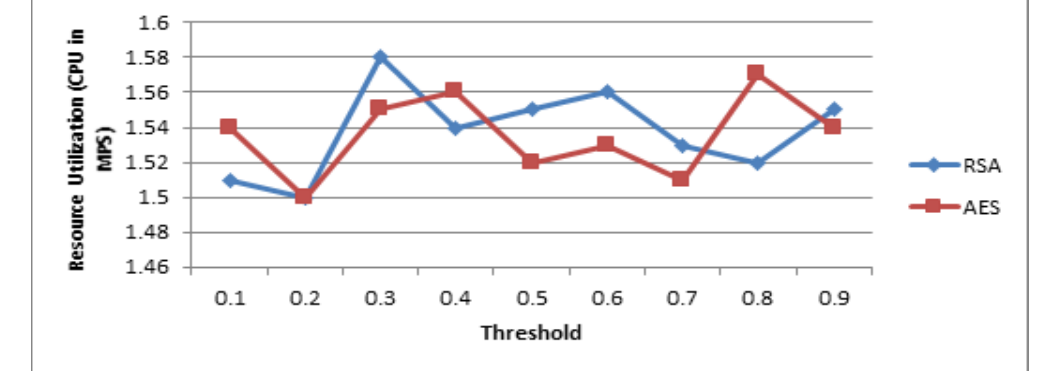
Figure 15 . Resource Utilization